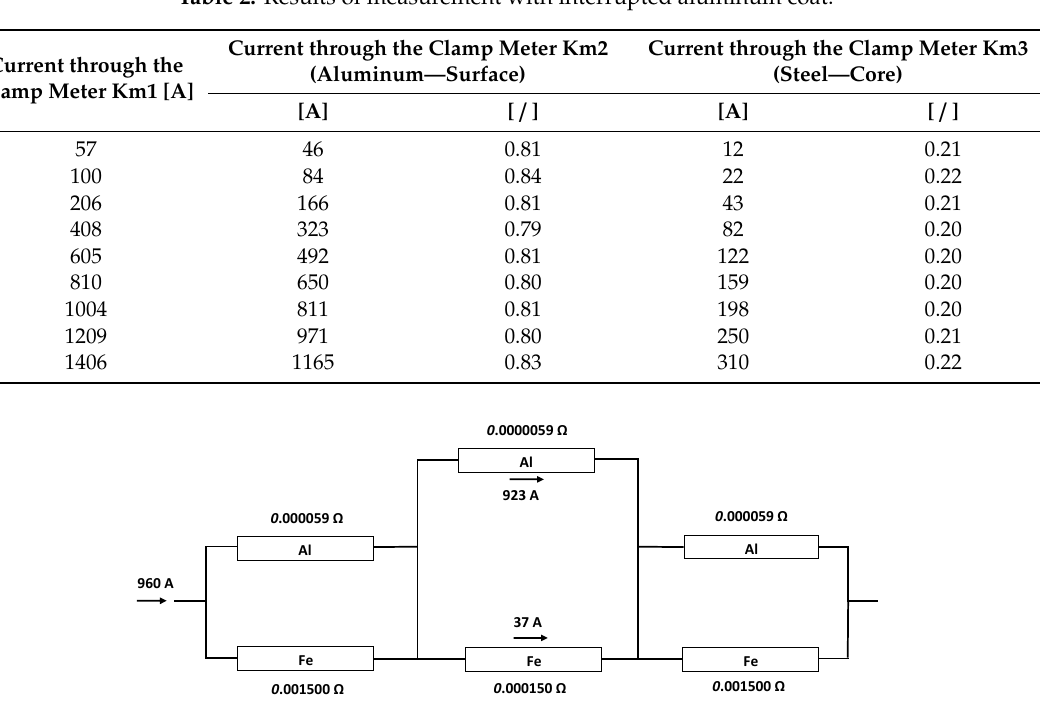
Figure 10. Measurement of current in parallel binding of aluminum coat and steel core.